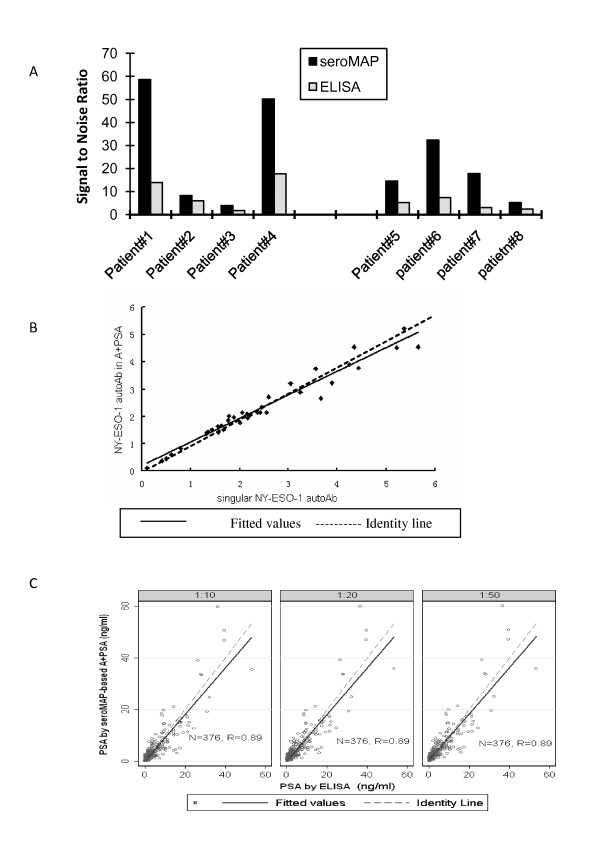
Characteristics of the sero-MAP based multiplex assay measuring autoAb plus PSA.(A). seroMAP and ELISA were compared for measuring autoAb against the prototype NY-ESO-1:1-40 peptide and the XAGE-1b:1-25 peptide. Specific MFI ratios (or OD) from randomly selected seropositive patients were divided by the mean of 8 HD to represent signal-to-noise ratios of the seroMAP and ELISA approach. (B). MFI ratios of autoAb against NY-ESO-1:1-40 versus a control obtained by the multiplex A+PSA and the singular assay had a correlation coefficient of 0.98 (n = 40), where the linear equation for NY-ESO-1 autoAb is A+PSA = 0.86*singular NY-ESO-1 + 0.20. (C). Comparison of seroMAP-based A+PSA and classic ELISA for determining total PSA values (ng/ml) using serum samples of randomly selected 376 subjects. The three fitted linear regressions for 1:10, 1:20, and 1:50 dilution were A+PSA = 0.89*PSA+0.15, A+PSA = 0.90*PSA+0.30, and A+PSA = 0.90*PSA+0.43, respectively. Methods of determining PSA levels using seroMAP-based A+PSA and classic ELISA (American Qualex) were described in "Materials and Methods".